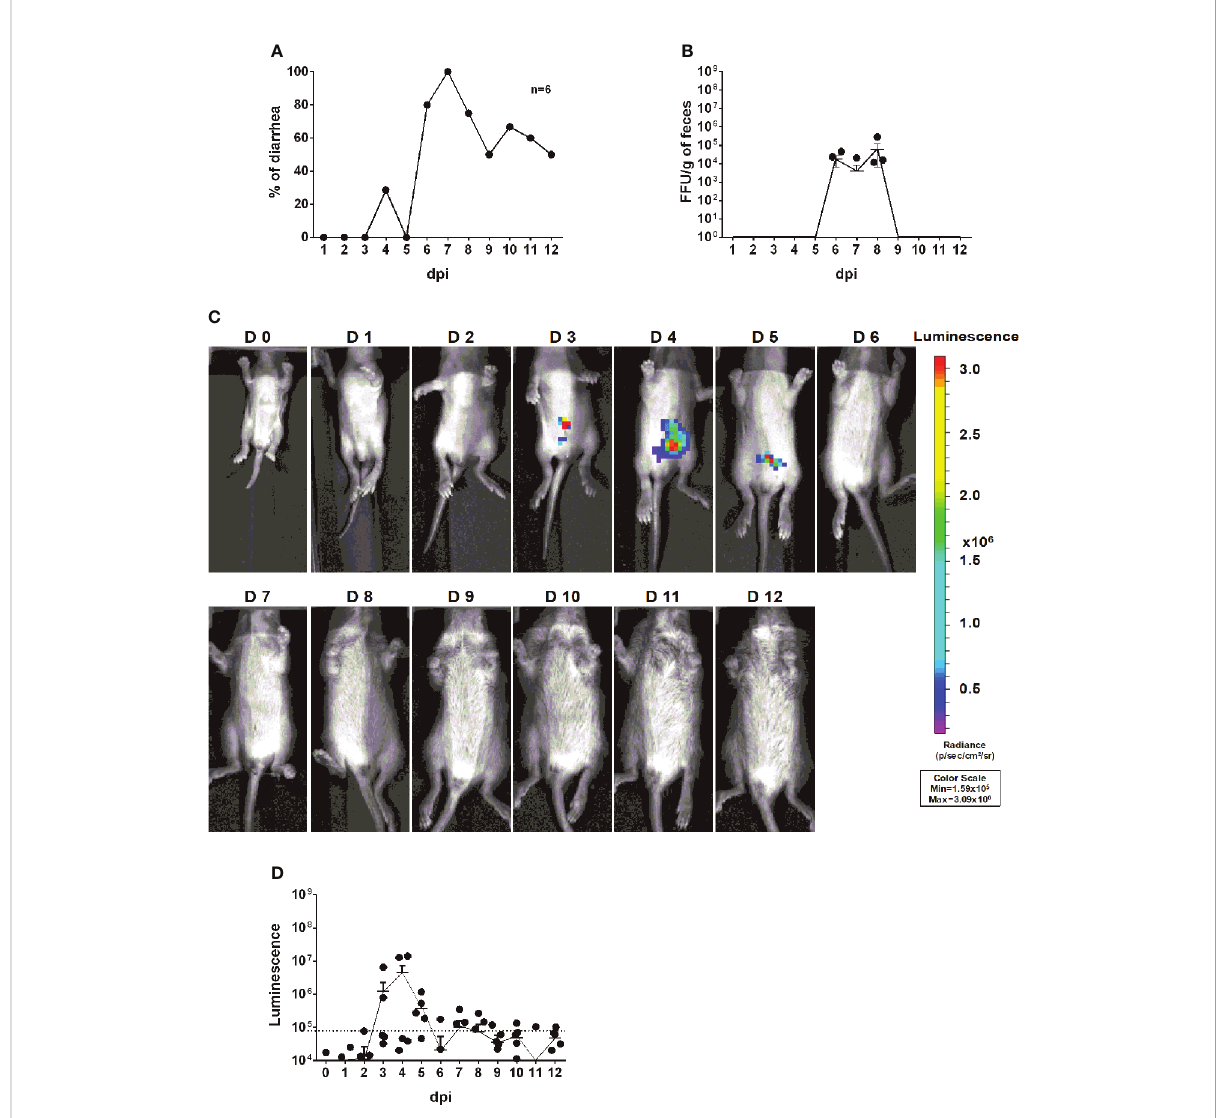
FIGURE 5 Transmission rD6/2-2g-NLuc in vivo . (A) Five-day-old 129sv mice were co-housed with 6 infected (3.5×10 3 FFUs of rD6/2-2g-NLuc) and 6 uninfected littermates in the same cage. The diarrhea rate was monitored from 1 to 12 days post infection. (B) Viral shedding in stool samples was detected by an FFU assay and normalized to the feces weight. (C) Representative images of naive pups (1 to 12 days). The bioluminescent signal is expressed in photons per second per square centimeter per steradian (p/sec/cm 2 /sr). (D) Quanti fi cation of the luminescence in (C) . The dashed line indicates the upper limit of